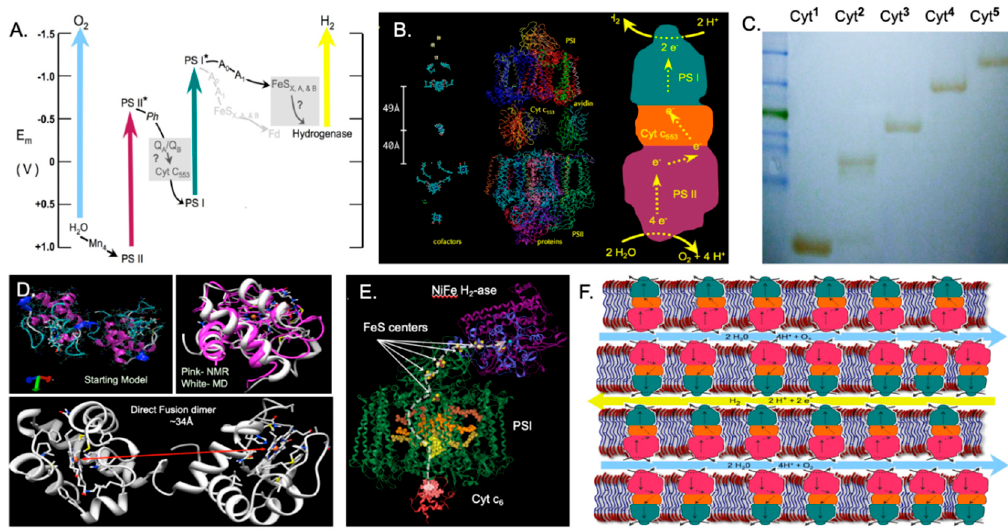
Figure 5. Design of the optimized photosynthetic energy converter (OPEC). ( A ) Energy level of the two photosystems in the Z-scheme, with changes shown in the two grey boxes: (1) the first box shows the result with the bypassing of the b 6 / f complex with cyt c 6 acting as the mobile carrier from PSII to PSI; (2) the second box shows the result of using bioengineering to lower the midpoint potential of the terminal FeS acceptors of PSI (F X, A, B ) to provide a larger driving force for H 2 production via a hydrogenase or catalyst (not shown). ( B ) An avidin-mediated coupling of PSII to PSI via multiple biotinylation of newly inserted, site-directed Cys mutants on the stromal side of PSII and the lumenal side of PSI is shown. The left panel shows the distances of the cofactors that would result from this cross-linking strategy (all distances are shown to scale). The middle panel shows the protein structures (PSII, cyt.c 6 , 3x-avidin, and PSI) based on published PDB files 1IZL, 1C6S, 2AVI, 1JB0). ( C ) As is clear from the distance in Panel B, the distance from QB to P700 is ~90 Å. To facilitate electron transfer over this long distance, we have designed and expressed a linker-less Cyt c6 polyprotein. These gene fusions are reflected by * and demonstrate the ability to make a penta-cyt c 6 polyprotein. ( D ) Demonstration of a short 90 msec MD simulation of a di-cyt c 6 fusion protein: the upper left panel shows the backbone trace of the starting fusion protein; the top right shows the superimposition of cyt c 6 monomers based on the starting NMR structure in pink and after the MD simulation; finally, the lower panel shows the Fe-Fe distance (~20 Å) of the two hemes following this 90 msec simulation. This would suggest that at least a tetra-cyt c 6 polyprotein would be needed to bridge the PSII–PSI distance shown in ( B ). ( E ) Illustration of the direct attachment of a NiFe hydrogenase to the stromal subunit PsaD of PSI with a docked cyt c 6 on the lumenal surface. The path of electron transfer is shown by the dashed grey arrow and the multiple FeS centers are shown with white arrows. ( F ) This schematic illustrates how these coupled PSII–cyt c 6 –PSI complexes could be assembled in a biomimetic polymer that provides a diffusion barrier much like a natural lipid bilayer may function. This complex may be embedded in the amphiphilic polymer (shown in purple) that could be alternated during the assembly process, projecting the oxygen-evolving sides of PSII into one microfluidic zone, analogous to the thylakoid lumen (blue) and the hydrogen evolving surface of PSI would be projected into a second microfluidic cavity analogous to the stroma (yellow).